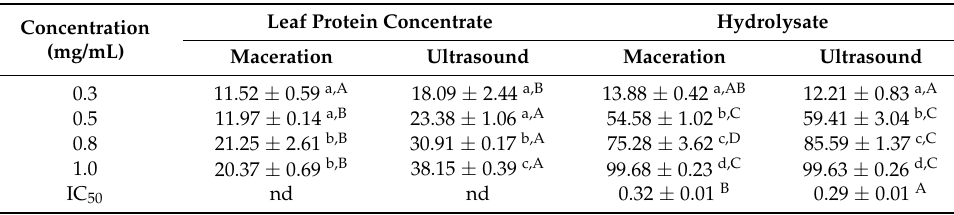
Table 4. ABTS + radical-scavenging activity (%) at different concentrations and IC 50 (mg/mL) of leaf protein concentrates obtained by maceration and ultrasound and their hydrolysates. Leaf Protein Concentrate Hydrolysate Concentration (mg/mL)